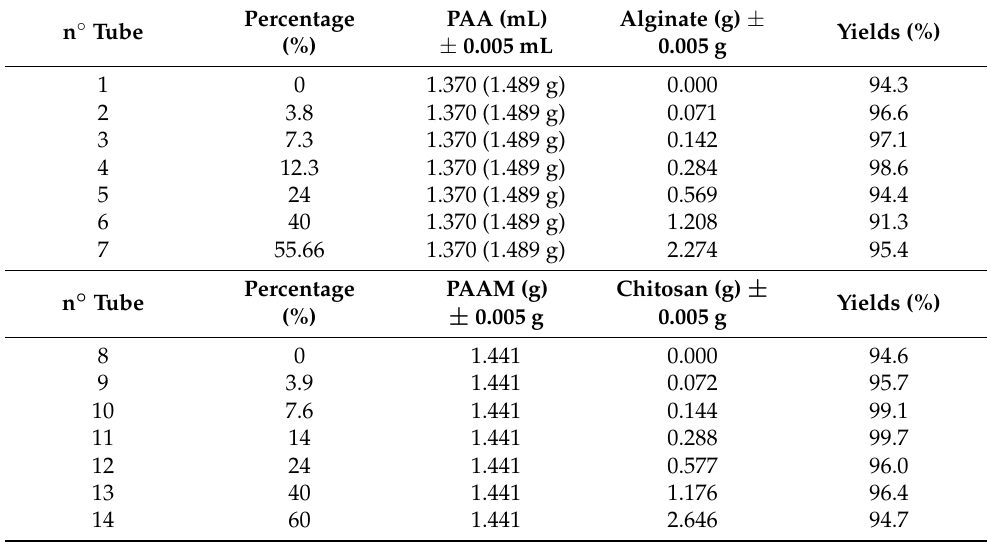
Figure 2. Synthetic scheme of hydrogels using biopolymers and monomers. Table 1. Details of the amounts of reagents used in each synthesis and its yield (%). MBA was 0.3114 g, and PSA was 0.0116